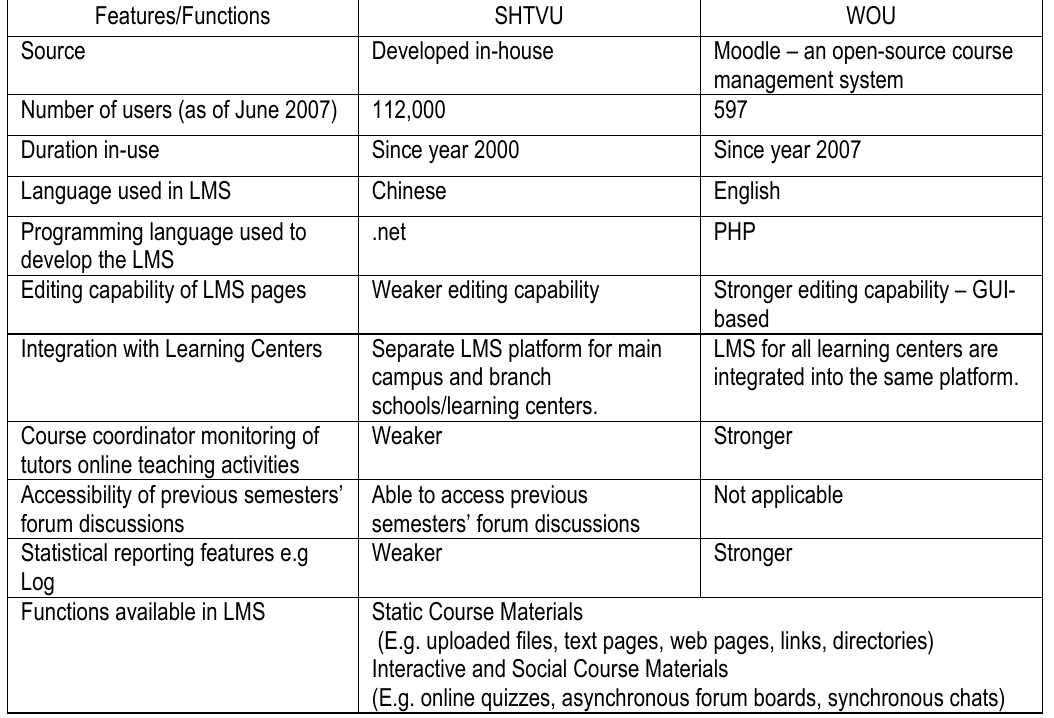
Table 2. LMS Features and Functions of SHTVU and WOU